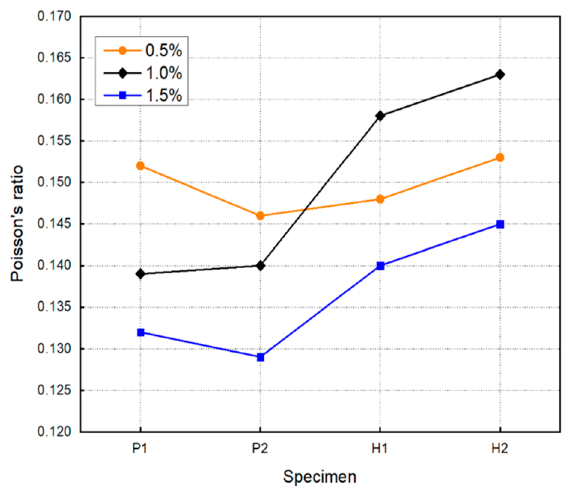
Figure 15. Poisson’s ratio.